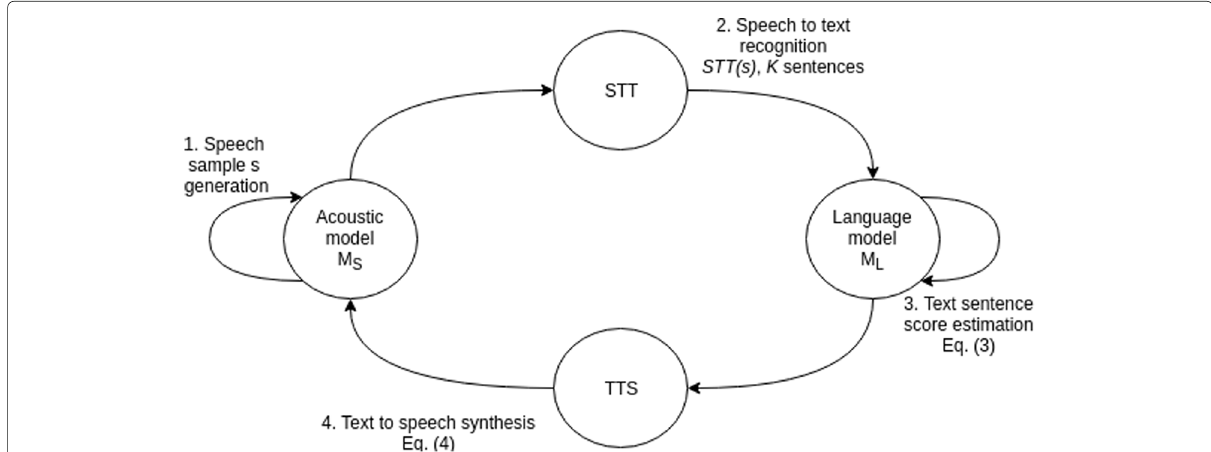
Fig. 2 Second kind of loop. Loop starts from generating a speech sample (loop S